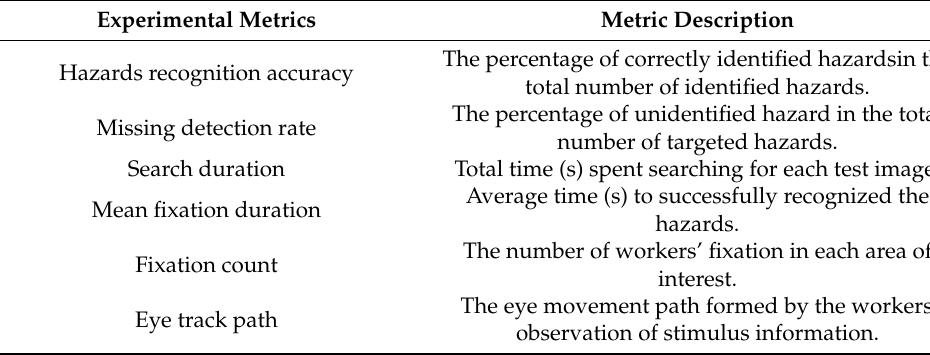
Figure 4. Design drawings of three test images. ( a ) Test image 1, ( b ) Test image 2, ( c ) Test image 3. Table 4. Experimental metrics and